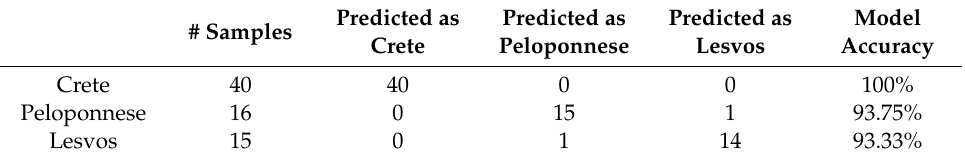
Table 2. PLS-DA classification of the olive oil samples using visible spectra.